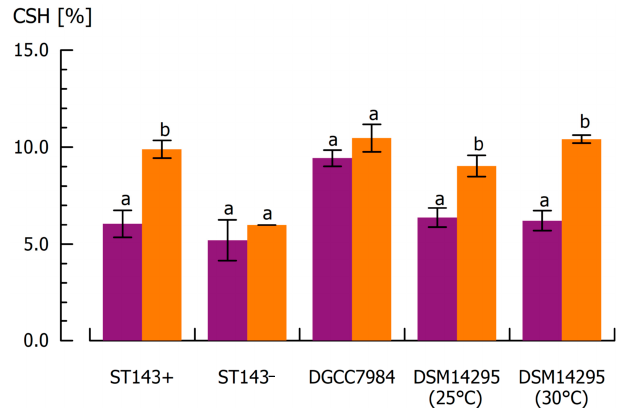
Figure 4. Cell surface hydrophobicity (CSH) of cells from S. thermophilus ST143 + , ST143 − , DGCC7984, and W. cibaria DSM14295 before (violet) and after ultrasonic treatment for CPS removal (orange). Mean values within the same strain with different superscripts differed significantly ( α = 0.05).